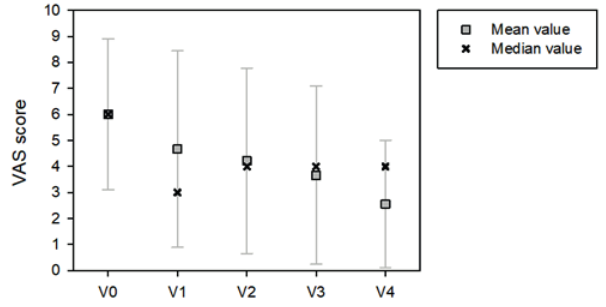
Figure 3. Evolution of the VAS score (mean and median values) at each control visit before removal (from V0 to 24h)